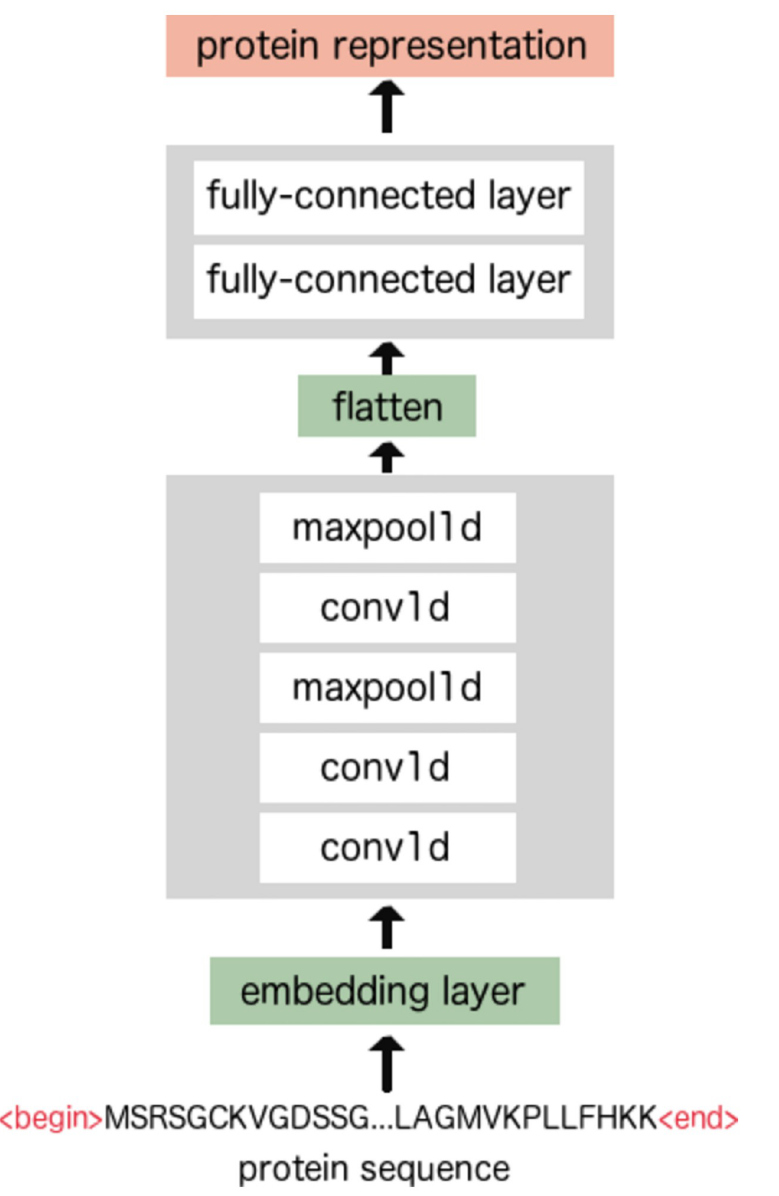
Fig 3. An overview of the 1D-CNN model that encodes protein sequences. longer than this maximum length are truncated, whereas shorter sequences are 0-padded. Additionally, we added two more special symbols into the input sequences in order to mark their begin and end position. As a result, the vocabulary for the embedding layer consists of 24 words in which 22 words correspond to amino acids and 2 words correspond to the begin/end symbols. The 22 amino acids include the 20 of the standard genetic code and an additional 2 that can be incorporated by special translation mechanisms, Selenocysteine (U) and Pyrroly- sine (O).